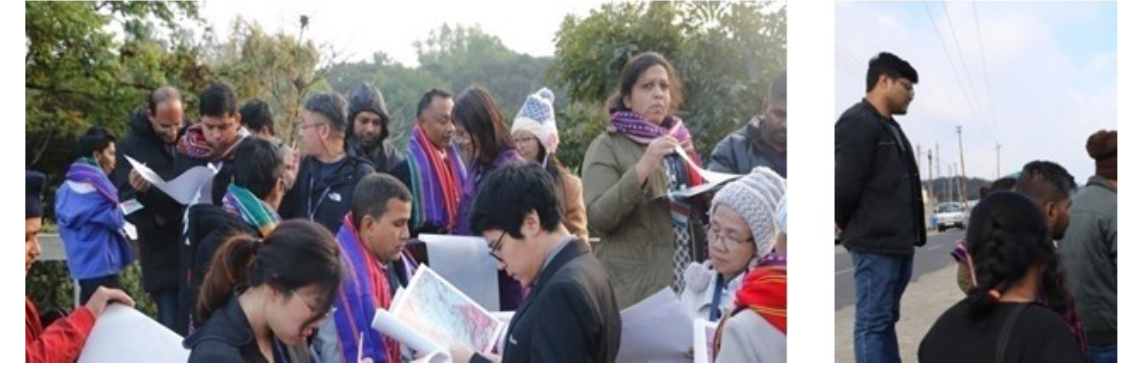
Figure 1. a) Understanding the interpretation of satellite data at Umiam lake, Meghalaya